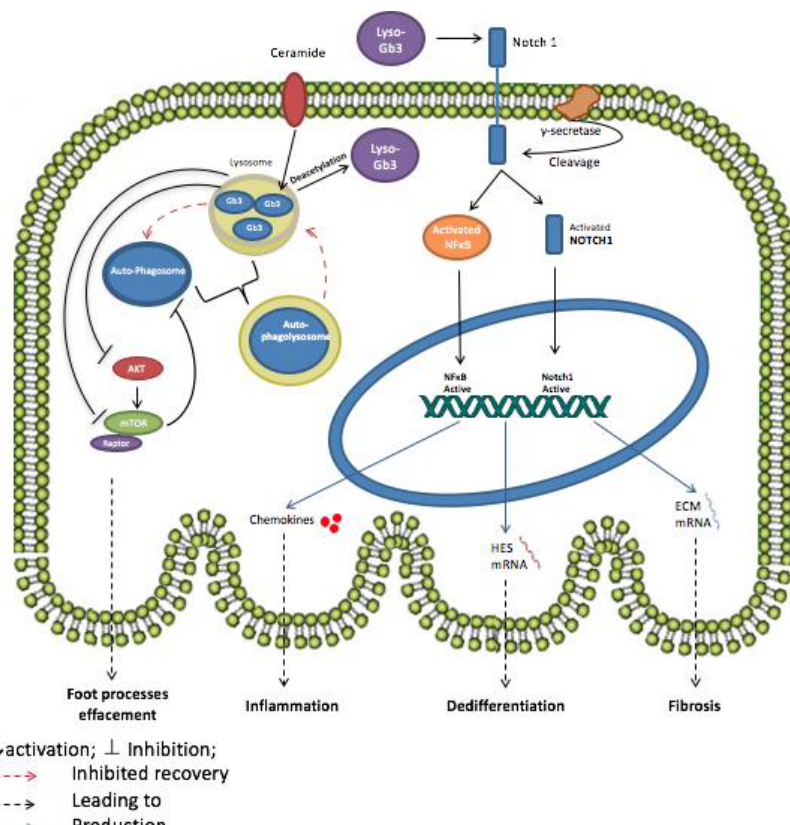
Figure 1. Potential mechanism of action of Globotriaosylceramide (Gb3) and Globotriaosylsphingosine (Lyso-Gb3) in Fabry’s disease podocyte. The accumulation of Gb3 in lysosomes inhibits AKT and mTOR pathway leading to the dysregulation of autophagy signaling in the podocyte. The inhibition of mTOR prevents the recovery of autophagosomes and lysosomes from autophagolysosomes by negative regulation. The formation of the autophagolysosomes causes podocyte foot processes effacement thus injury. Lyso-Gb3, the deacetylated form of Gb3, also plays a role in podocyte injury by promoting inflammation, fibrosis and dedifferentiation of podocytes. Lyso-Gb3 activates both the NOTCH signaling pathway, through γ -secretase, and nuclear factor κ B (NF κ B) leading to the release of chemokines. NOTCH-1 activation also promotes the transcription of HES genes and genes coding for extracellular matrix (ECM) proteins thus inducing, respectively, the dedifferentiation and fibrosis of the podocyte.